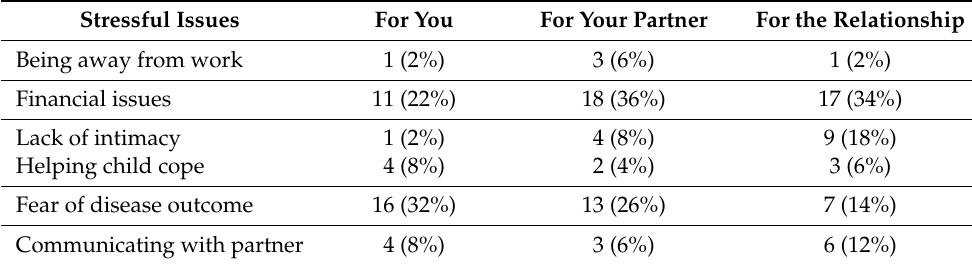
Table 2. Stressful issues for self, partner, and relationship ( n =